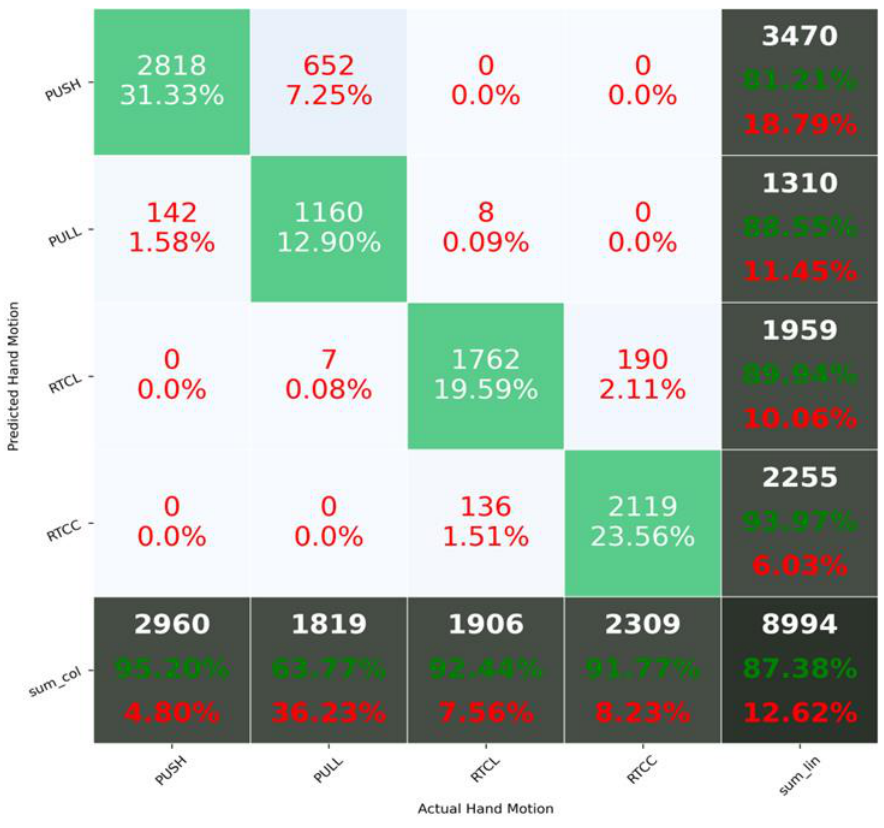
Figure 5. Prediction performance of the deep learning network with four typical hand motions used during intravascular catheterization.